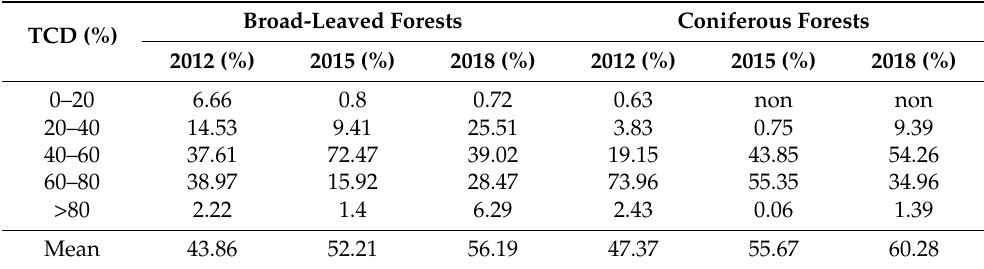
Table 3. Tree-cover density (TCD) classes (%) and area of their distribution (%) within broad-leaved and coniferous forests in 2012, 2015, and